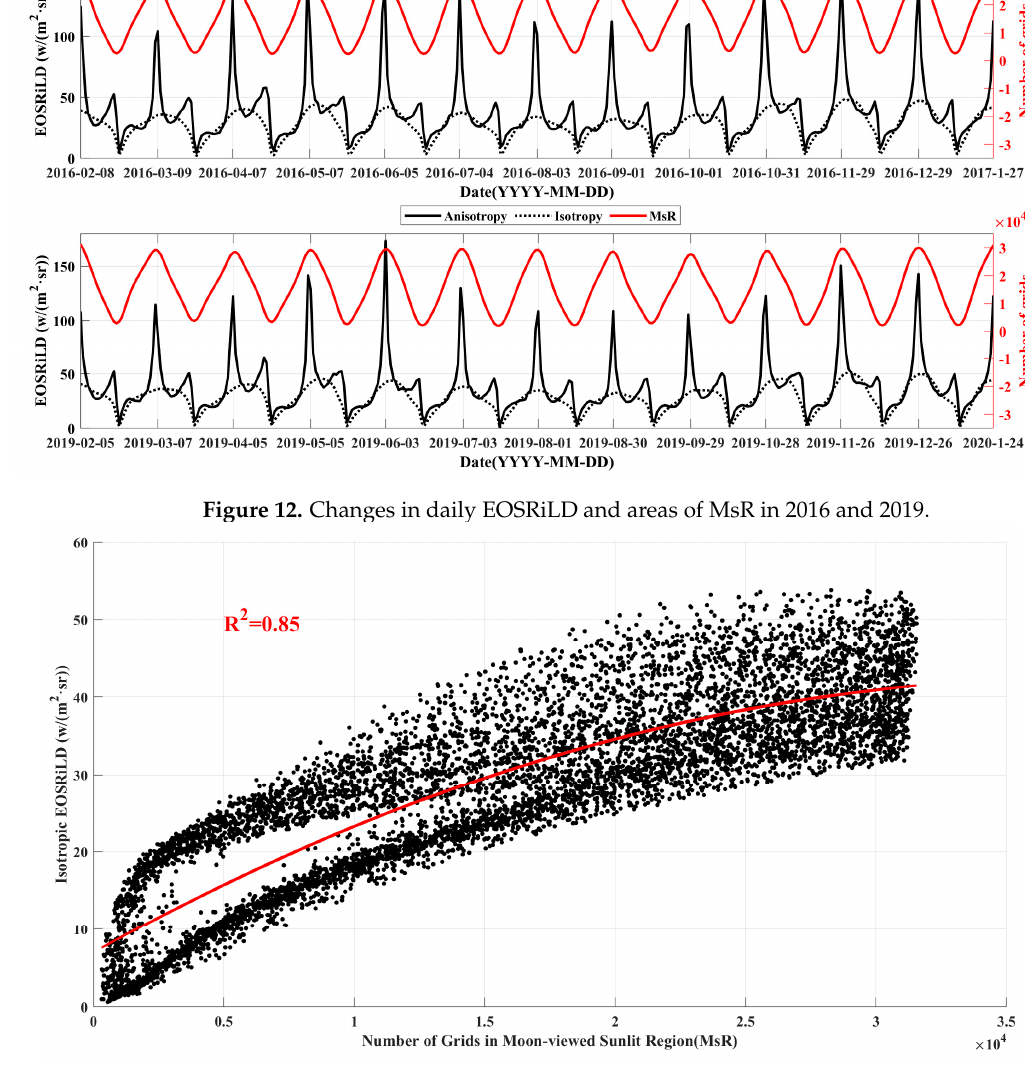
Figure 13. Scatter plot of daily isotropic EOSRiLD and number of grids in MsR from 2000 to 2020.